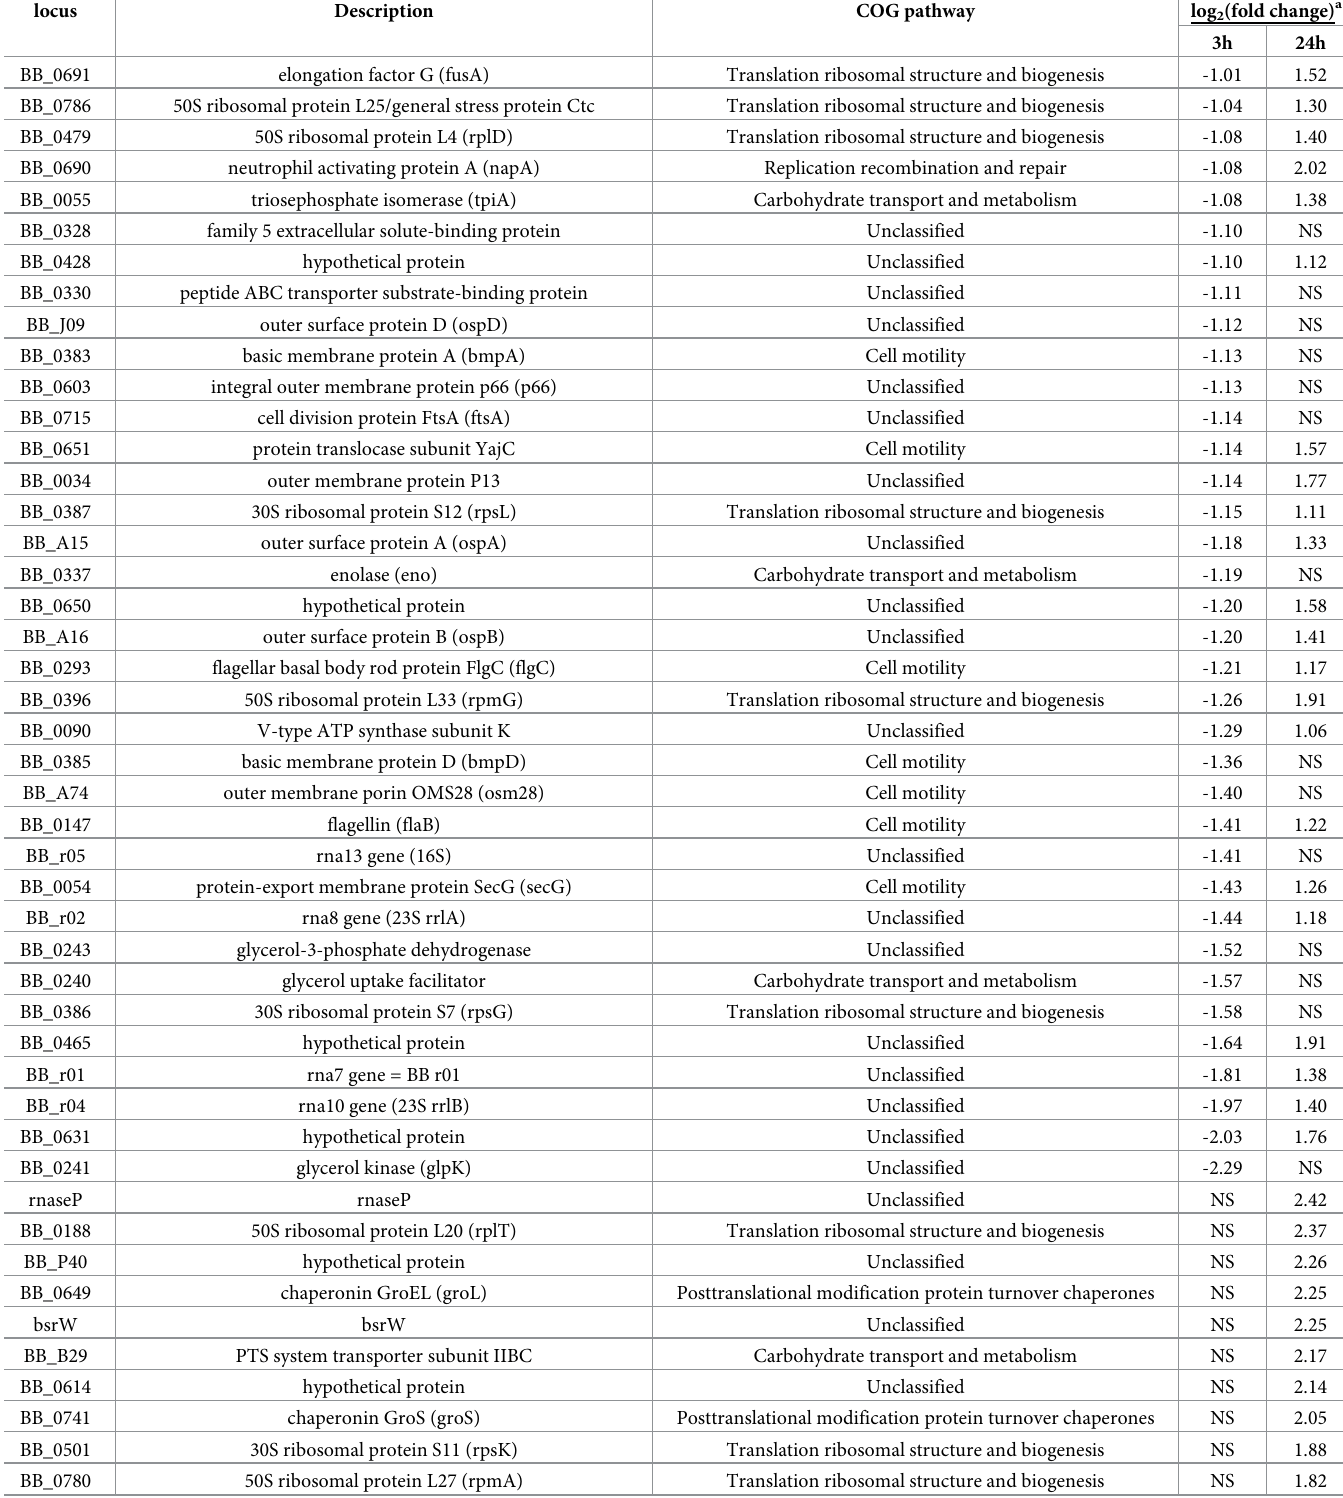
Table 1. Differentially expressed genes in doxycycline treated B . burgdorferi versus untreated controls.